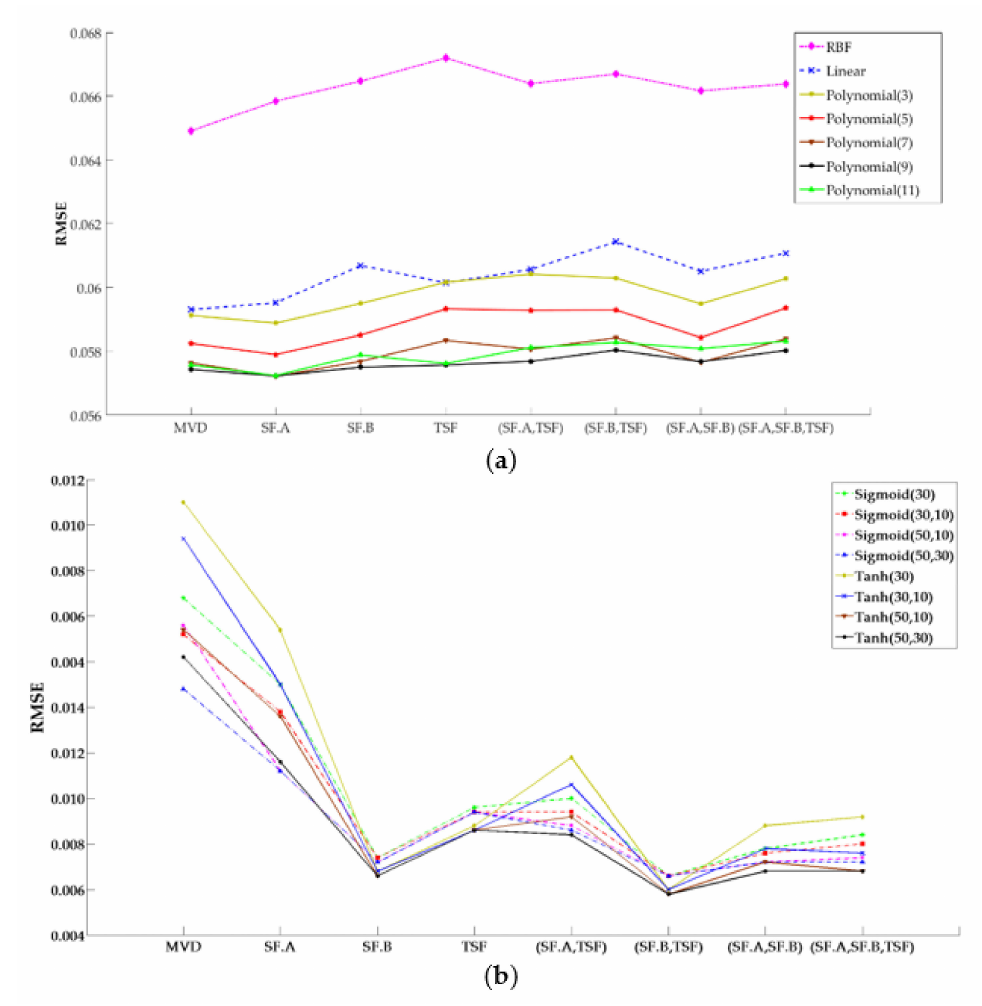
Figure 9. Parameter tuning results: ( a ) support vector regression (SVR); ( b ) artificial neural net- work